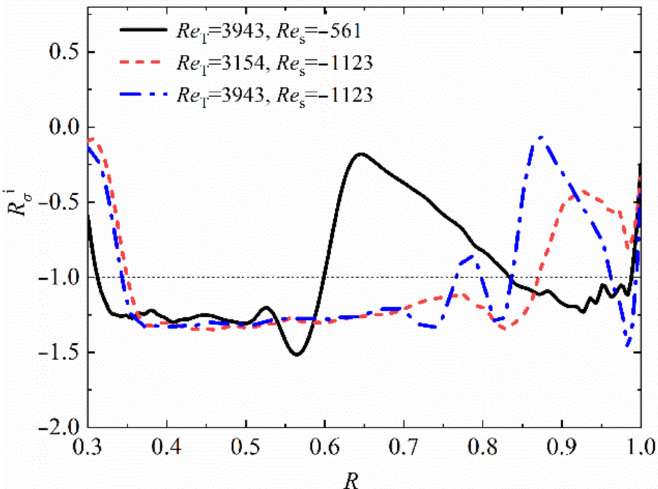
Figure 8. Local capillary ratio distribution along the free surface for the cases shown in Figure